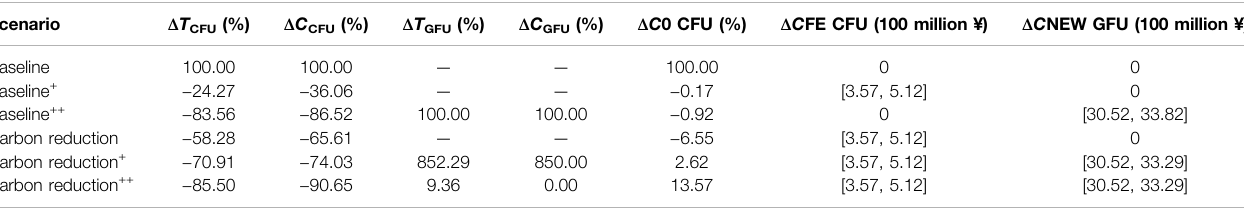
TABLE 3 | Simulated costs of fl exibility system in the